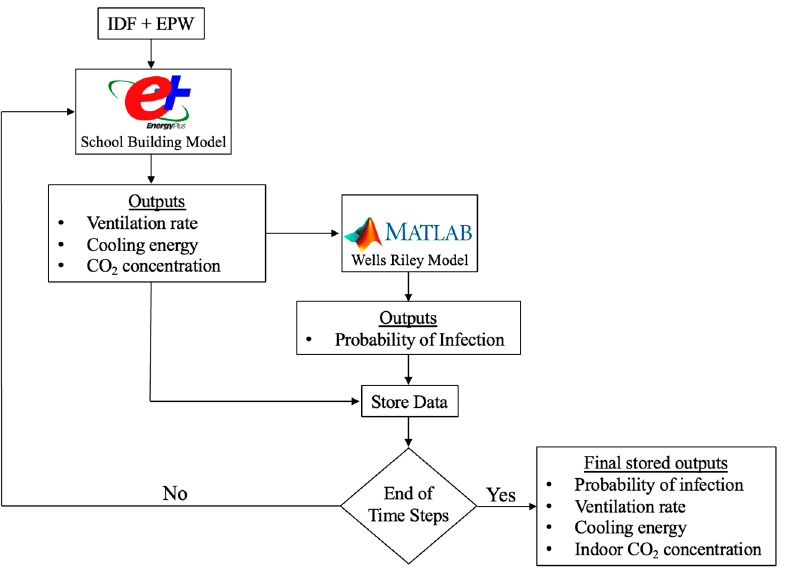
Figure 3. Schematic diagram of the co-simulation approach using EnergyPlus whole-building energy analysis coupled with Matlab’s script of the Wells–Riley model.